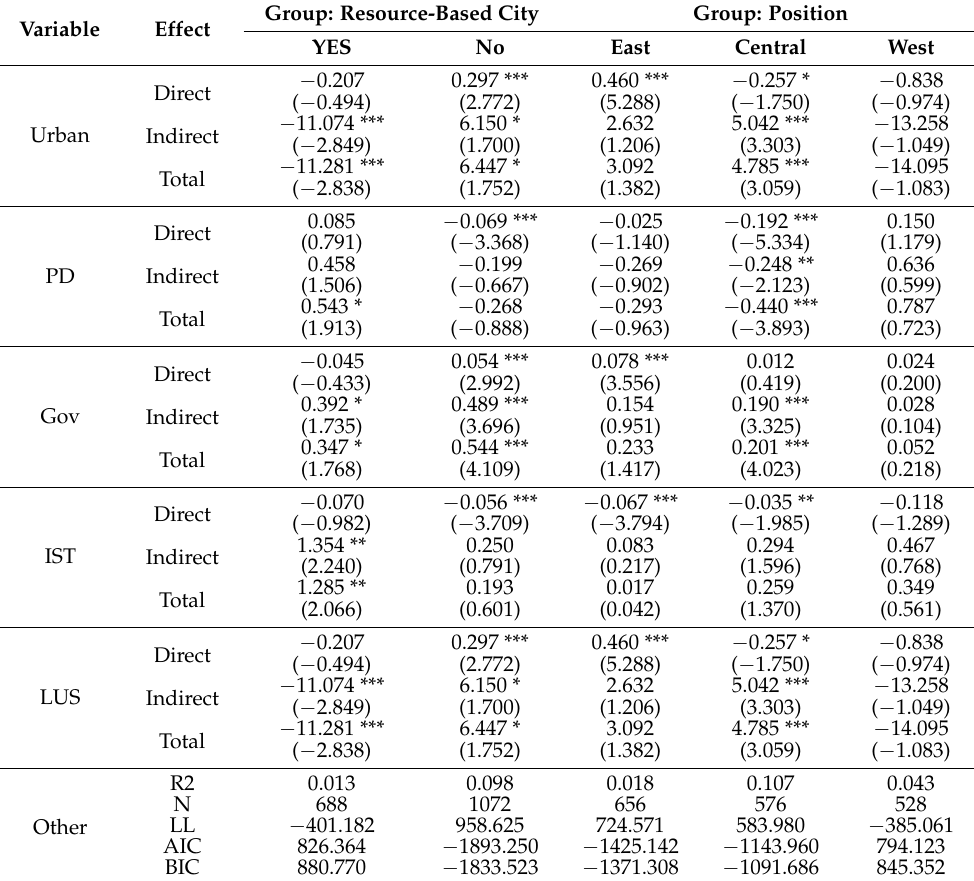
Table 7. Heterogeneity test